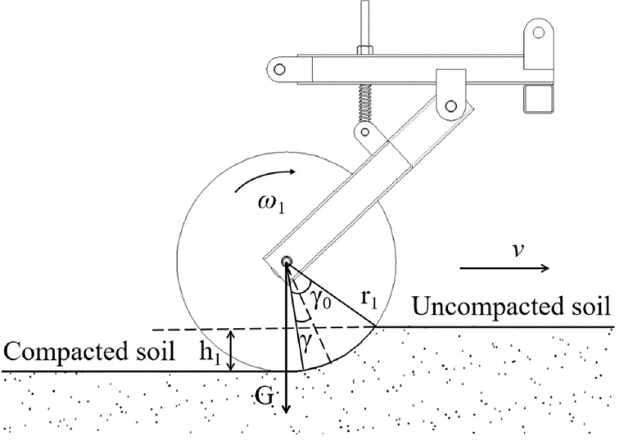
Figure 7. The process of soil compacting.